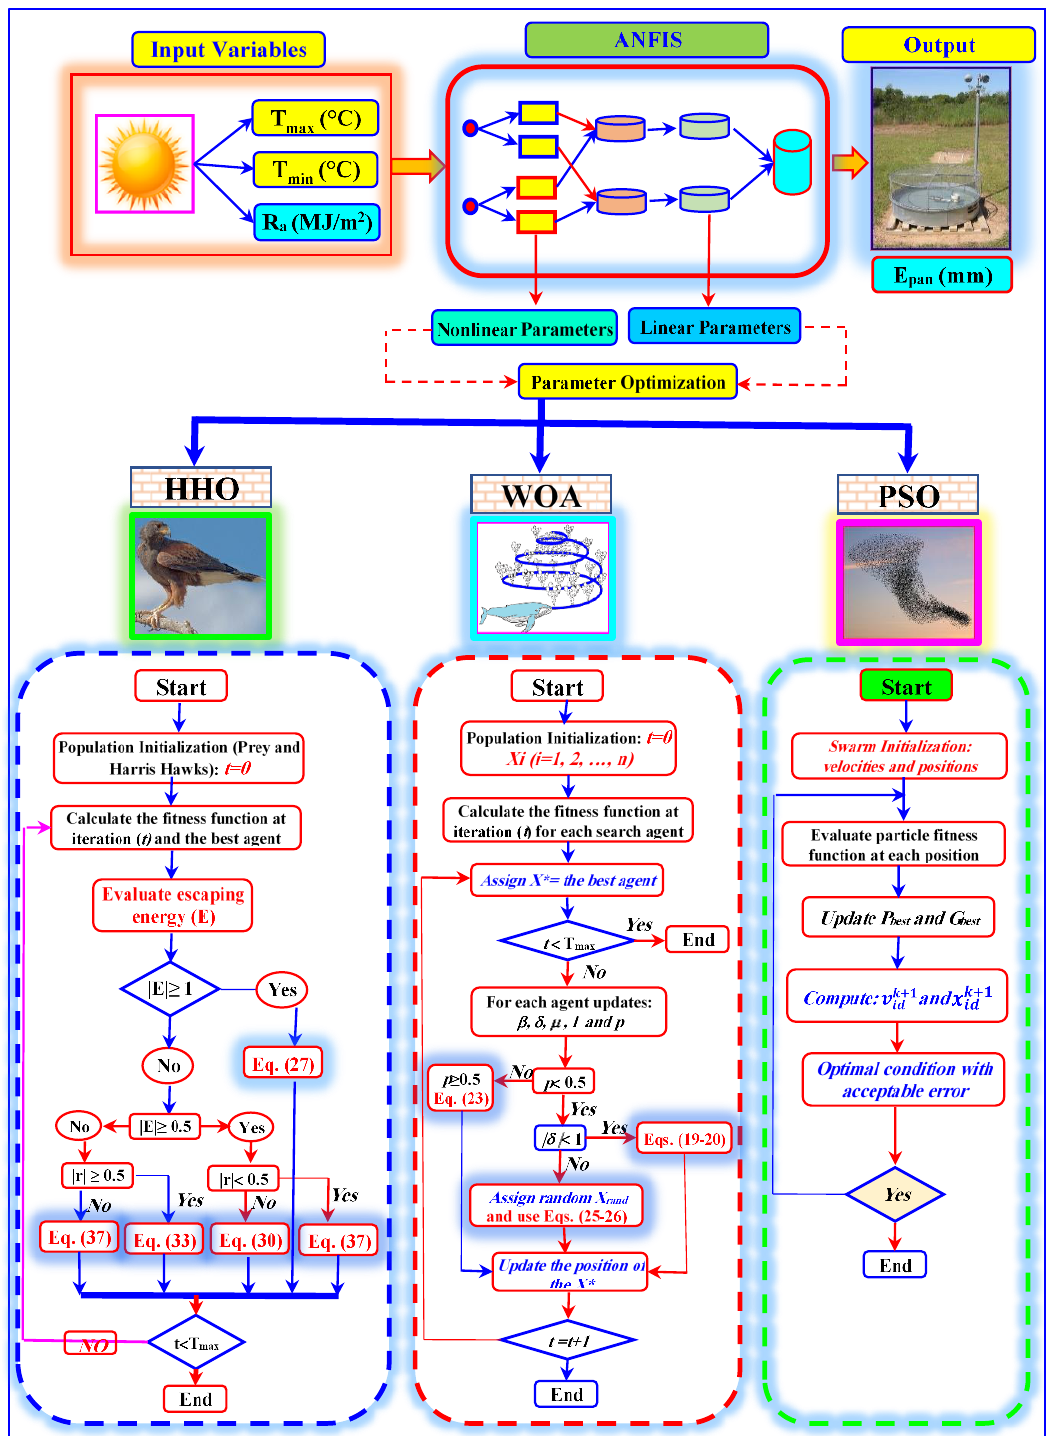
Figure 2. Flowchart of the methodology adopted in this study. Table 3. Parameter settings of ANFIS and three optimization algorithms used in this study.